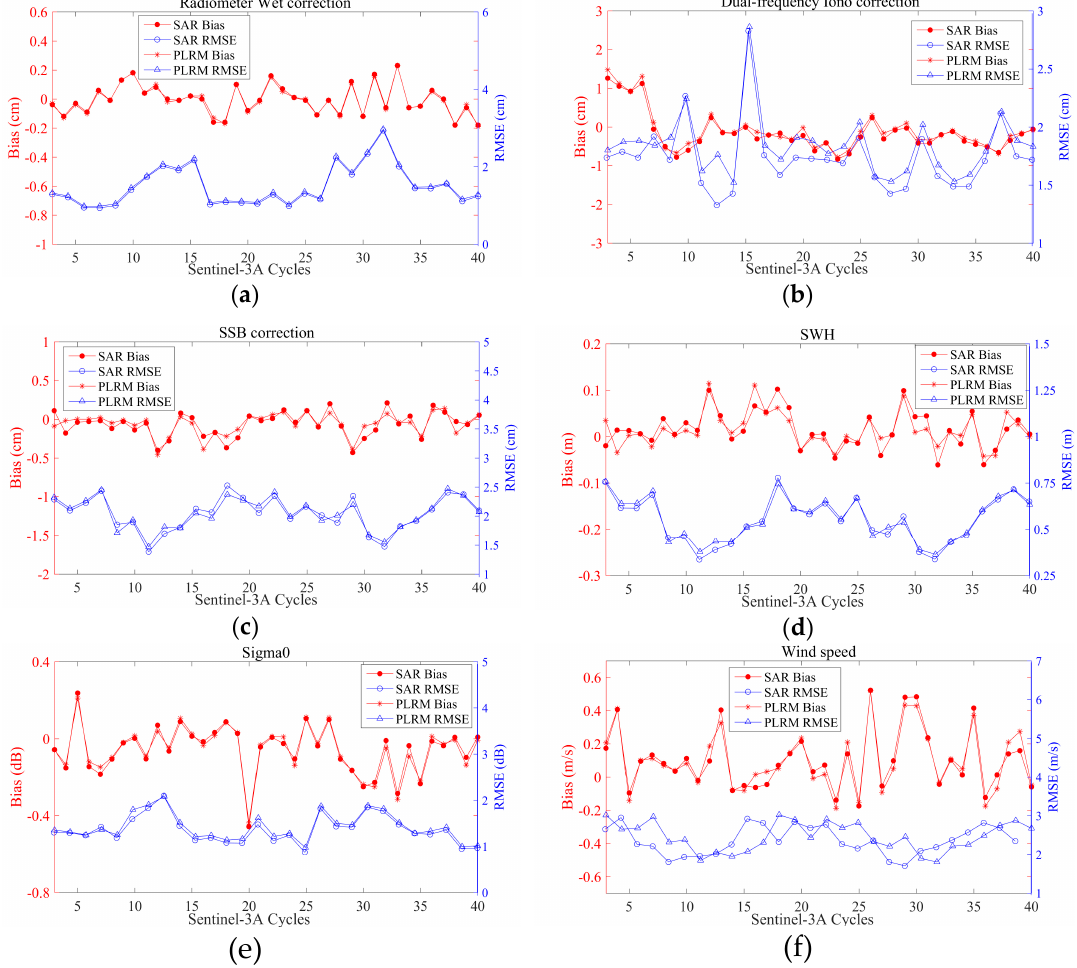
Figure 18. Cycle by cycle biases and RMSEs of differences of ( a ) radiometer wet tropospheric correction, ( b ) dual frequency ionospheric correction, ( c ) SSB correction, ( d ) SWH, ( e ) Sigma0 and ( f ) wind speed at the self-crossovers of